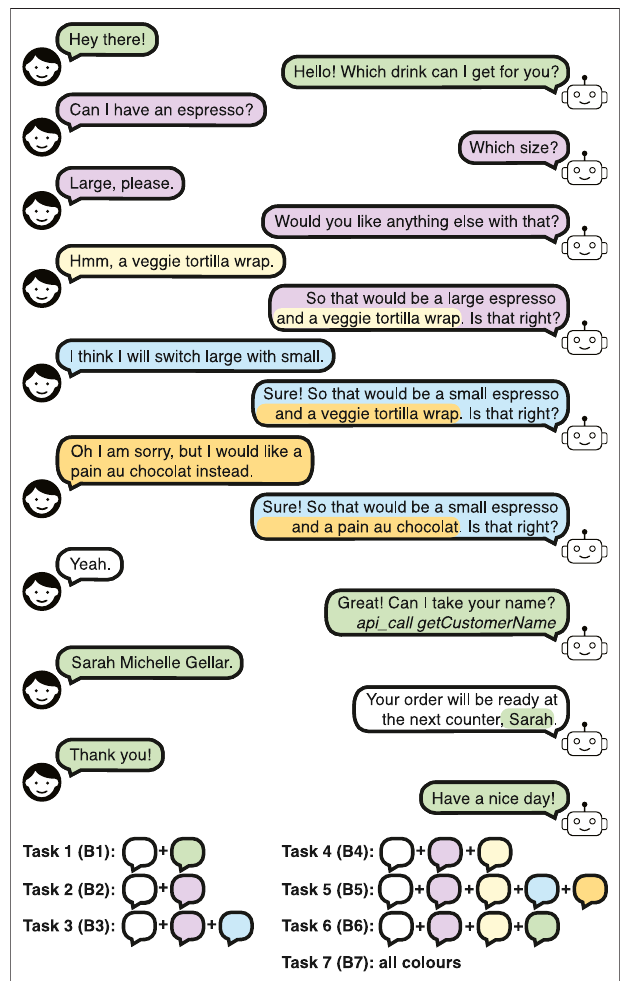
FIGURE 1 | A dialogue example in the Barista Dataset Task 7, showing all the tasks in the